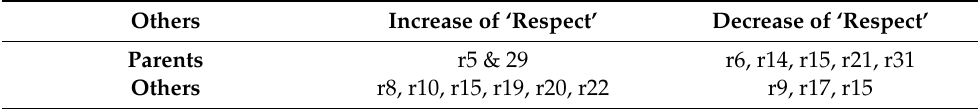
Table 2. Respect for others in the second life